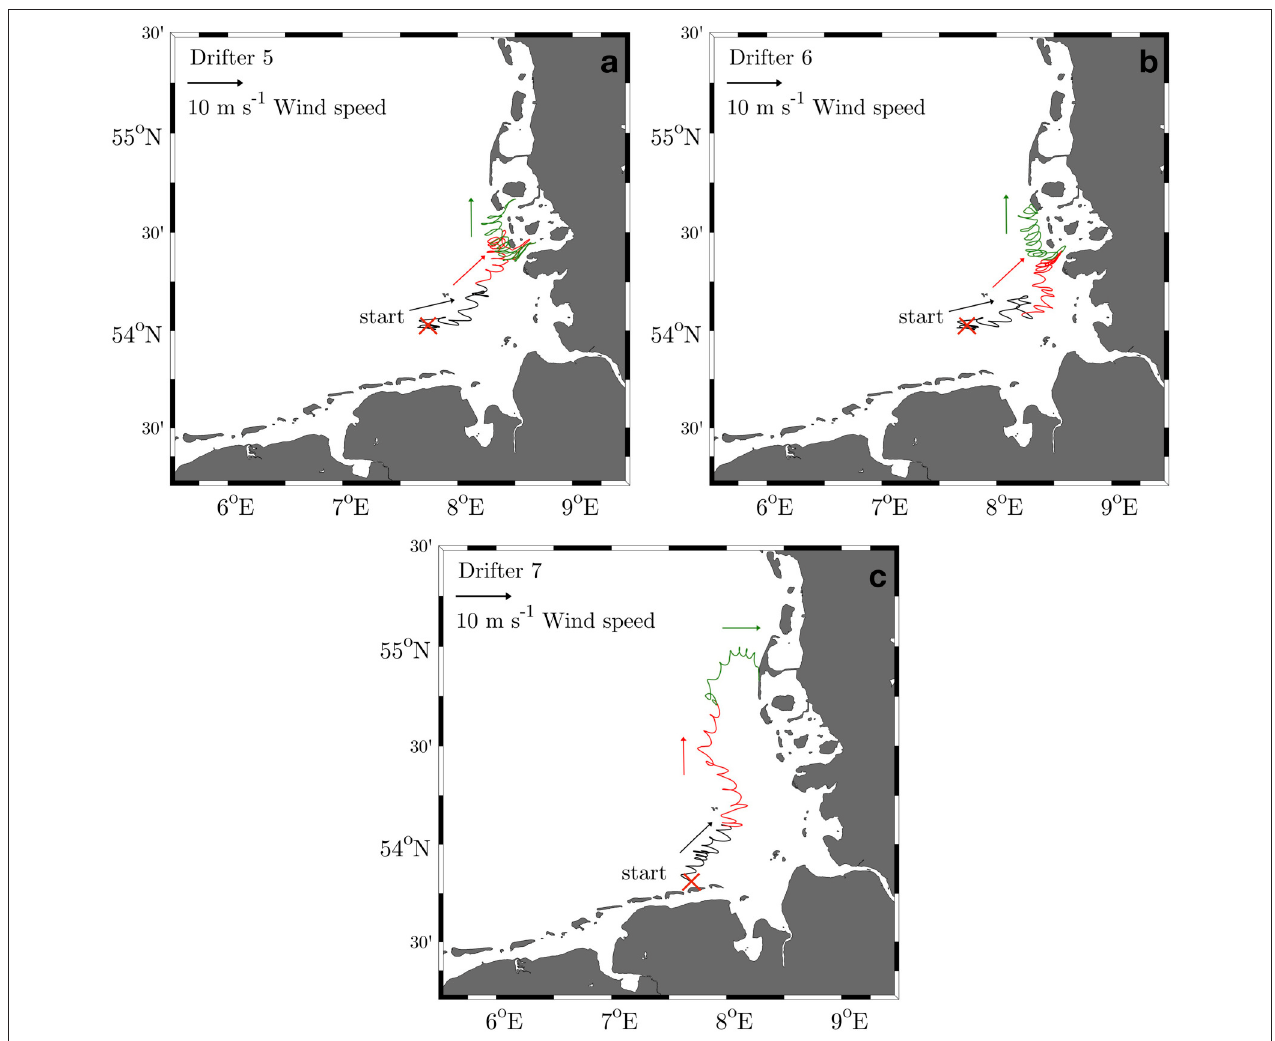
FIGURE 7 | Trajectories of 3 drifters deployed in October 2017. (a–c) The release location is indicated by a red cross for every trajectory. The trajectories were subdivided into 5-day segments which are indicated by different colors. The corresponding colored arrows show the mean prevailing wind directions for the associated 5-day segments.